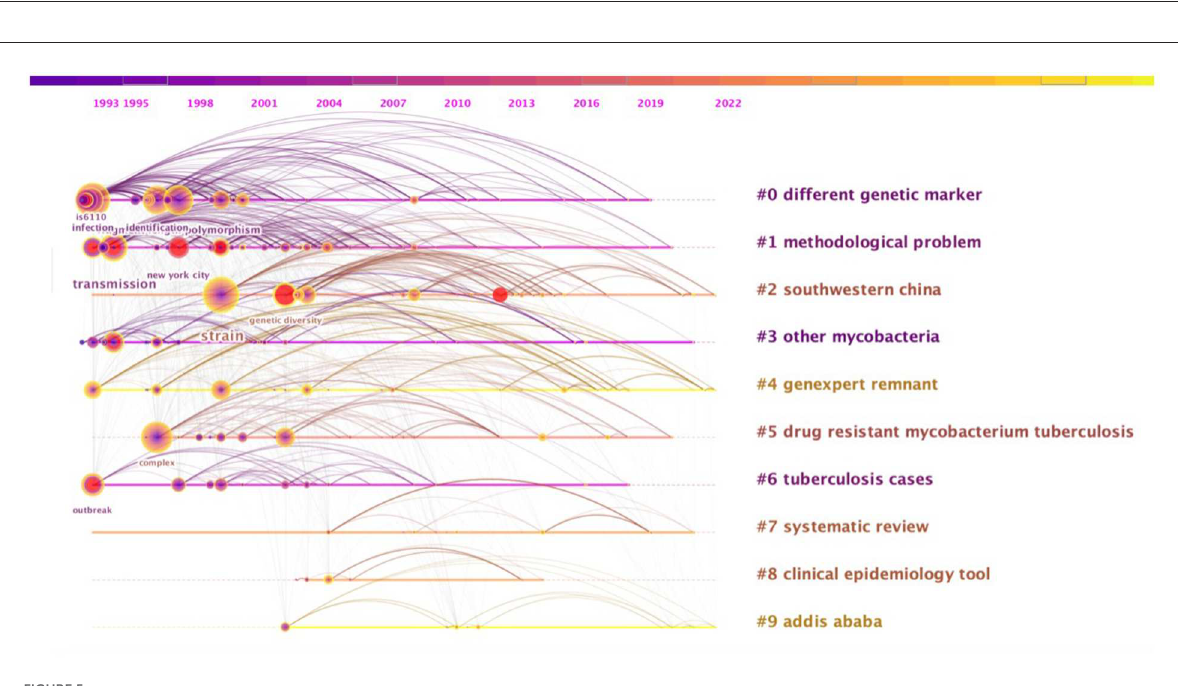
development of molecular epidemiology and innovation of methodological